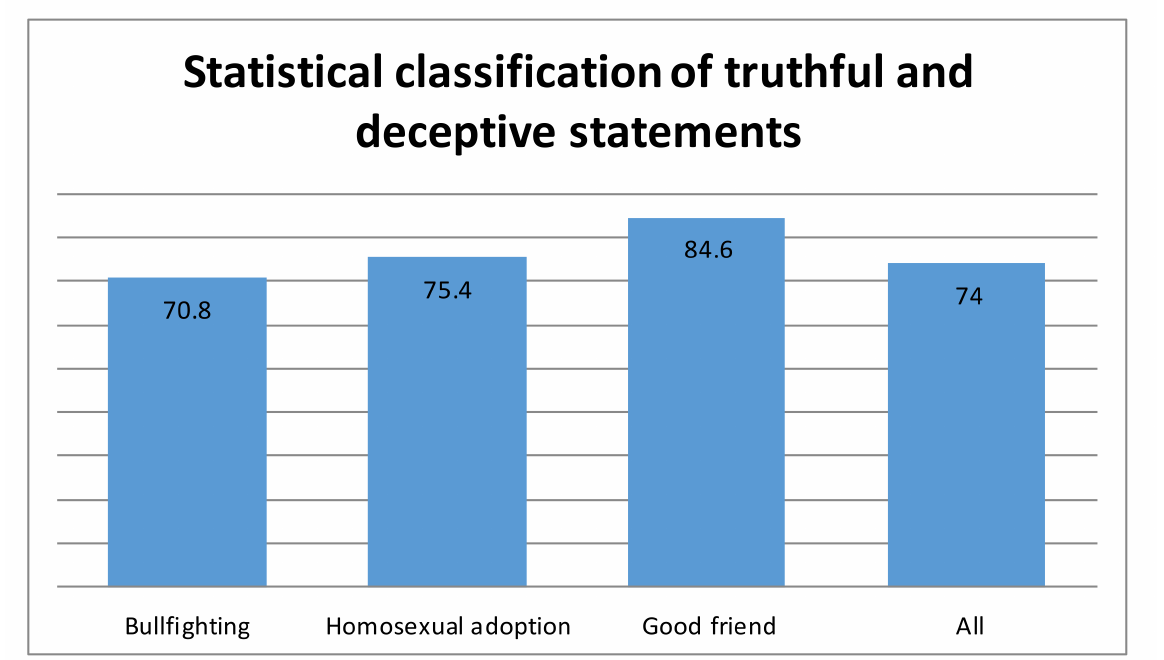
Figure 4. Cross-validated classification of truthful and deceptive